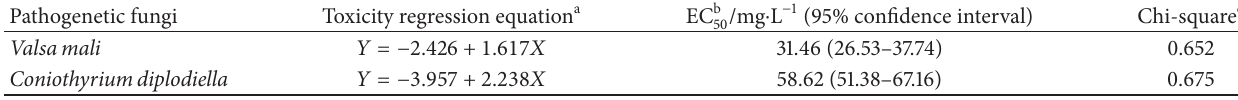
Table 2: Antifungal activities of 5-fluoro-2-hydroxy butyrophenone against two pathogenetic fungi.